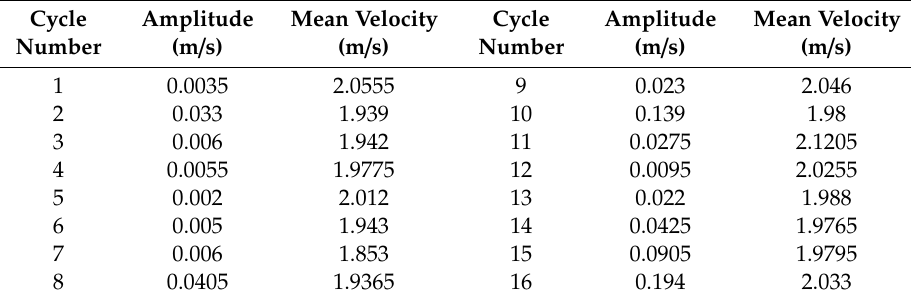
Table 2. Cycles counted in a turbulence sample at 2 m /